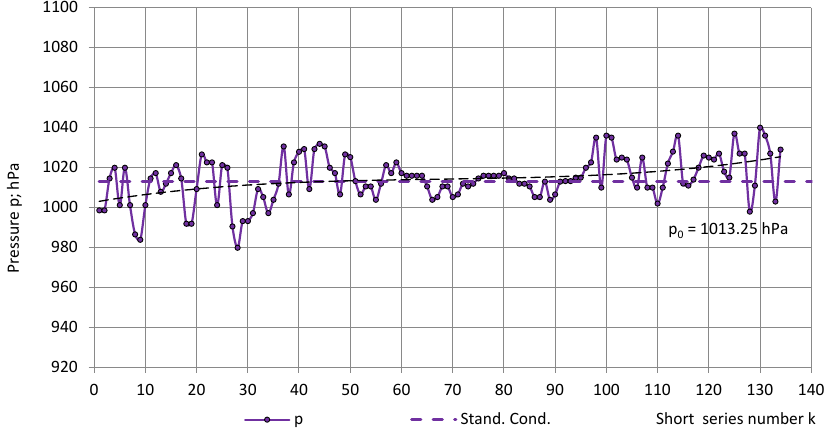
Figure 4. Atmospheric temperature T (red) and relative humidity RH (blue) in the test room in the short series. In the short series, the relative humidity varied in the limits of low to medium values 21% ≤ RH ≤ 60%. The average temperature and relative humidity were calculated as T av =